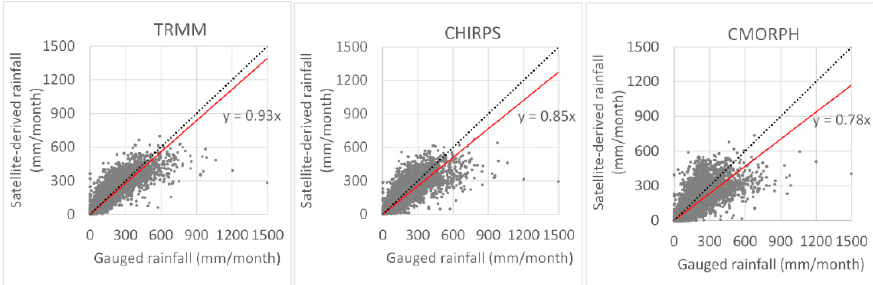
Figure 4. Comparison of monthly rain gauge data with three satellite products for the overlapping period January 2003–December 2014. The dashed line indicates a 1:1 correspondence and the red line gives the linear regression best fit with 0 intercept.